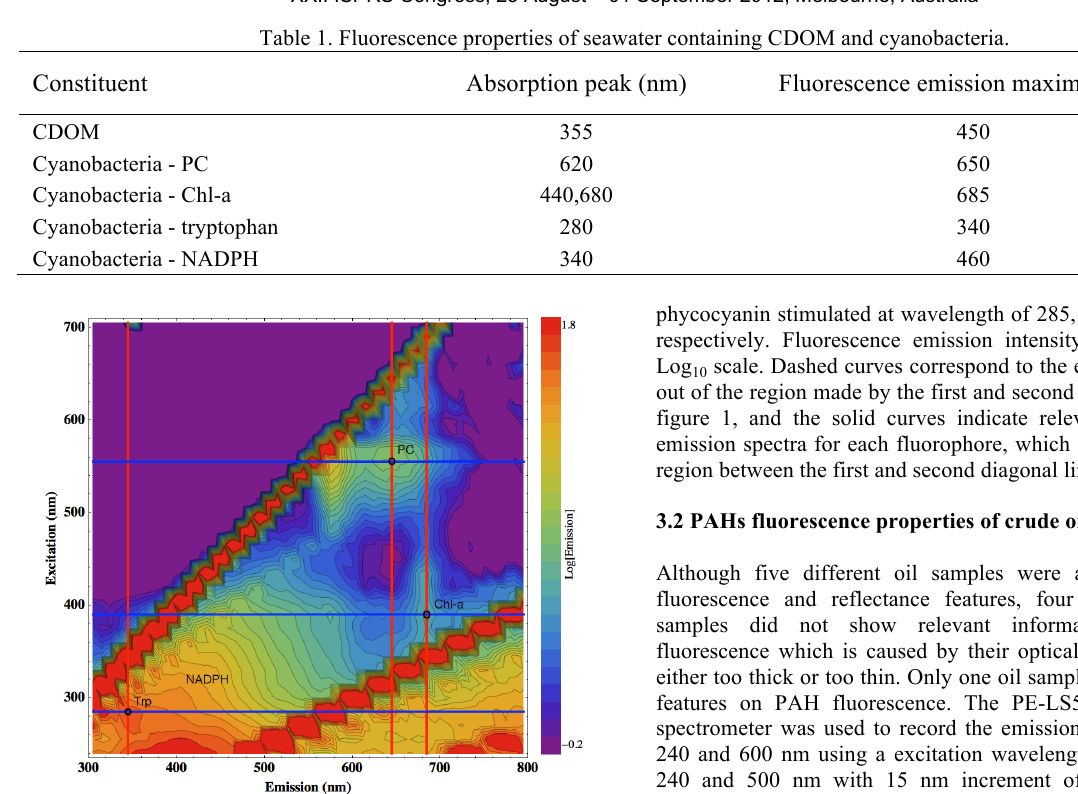
Figure 1. Excitation-Emission Matrix (EEM) of the concentrated seawater sample, and intensity of fluorescence emission is shown on an arbitrary Log 10 scale. The blue horizontal lines display the excitation wavelengths at 280, 390, 550 nm that induced fluorescence peak from measured samples, and the red vertical lines show the fluorescence emission with the corresponding excitation.